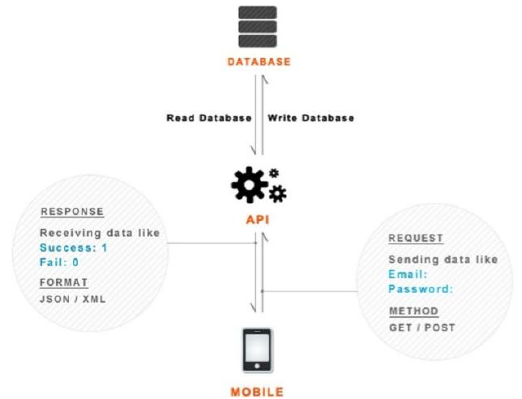
Figure 1. Database communication